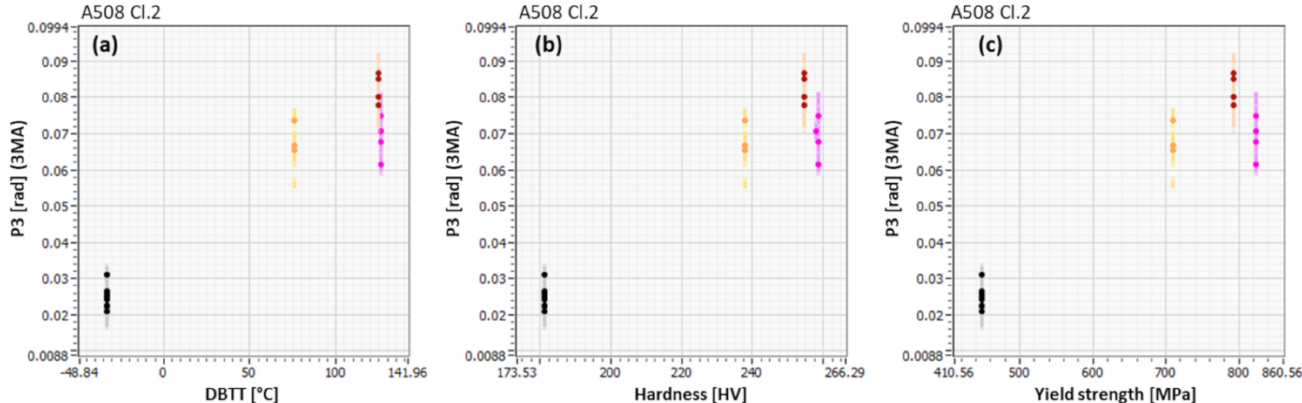
Figure 13. Dependency of the amplitude of third harmonics P3 on the ductile to brittle transition temperature (DBTT)( a ), hardness ( b ), and yield strength ( c ) of western RPV material A508